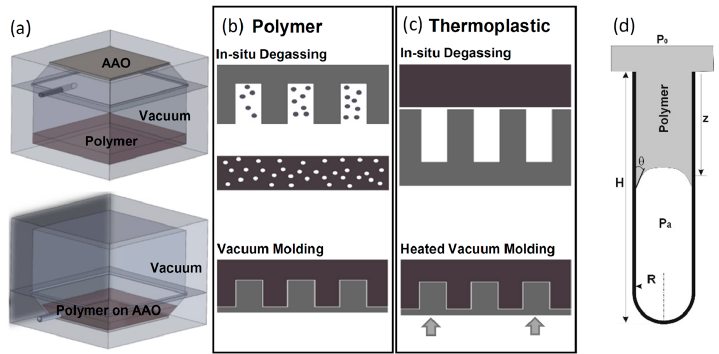
Figure 3. Polymeric nano-wire fabrication technique using vacuum-assisted molding into an